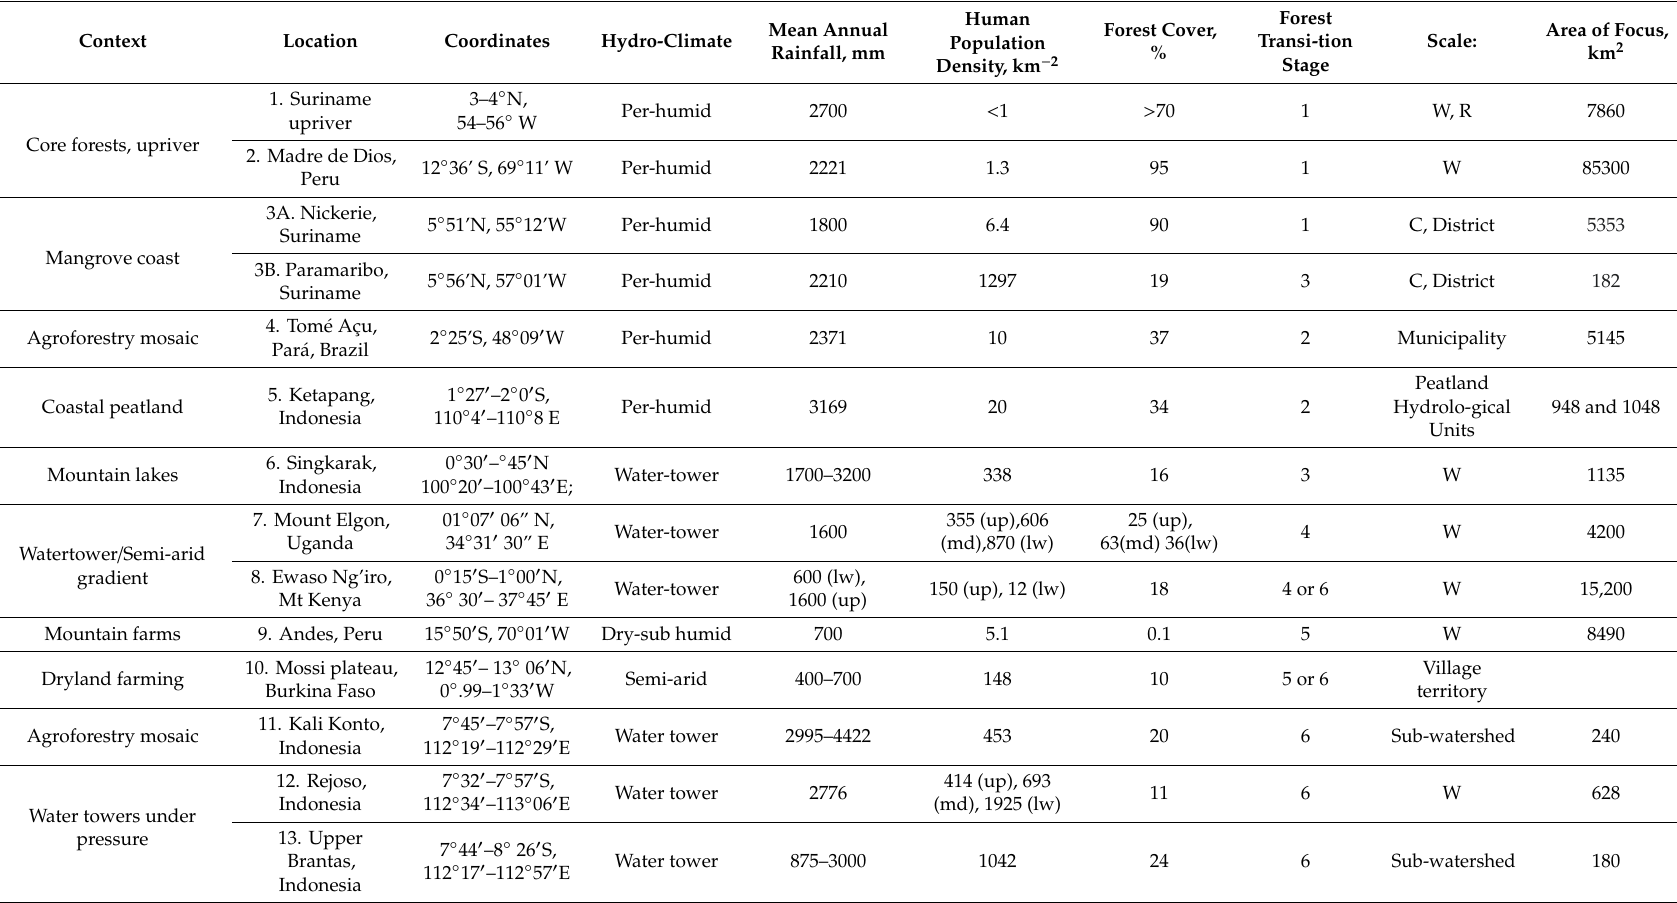
Table 1. Basic properties of SESAM landscapes; W = water-shed, R = Region, C = coastal